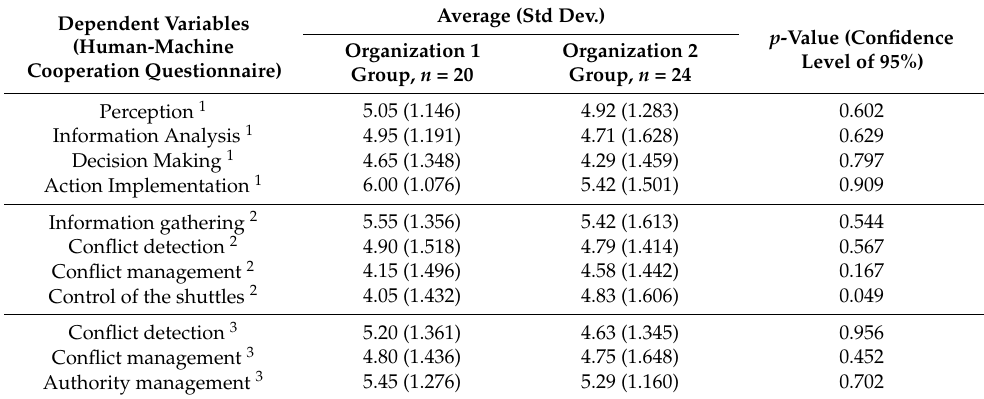
Table 3. Averages of the perceived Human-Machine cooperation measures and the significant results.